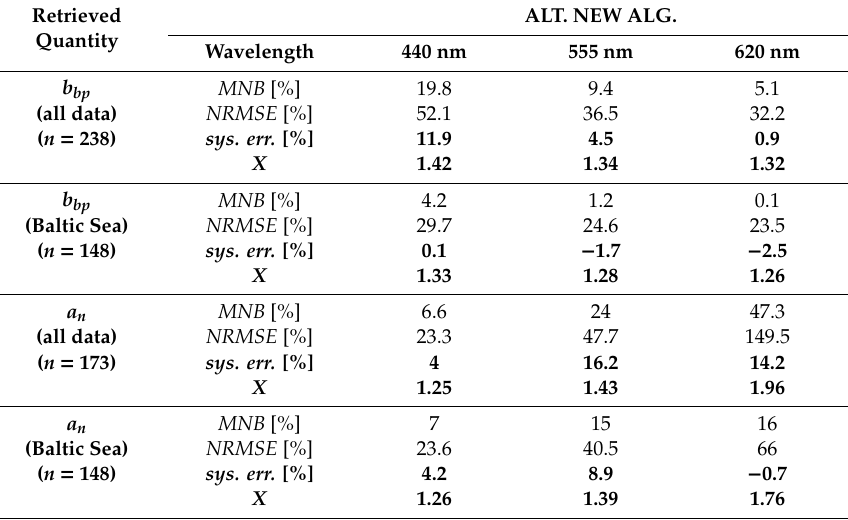
Table A2. Summary of estimation errors of coe ffi cients b bp and a n obtained when the alternative version of the new algorithm were applied to the entire dataset used in this work, as well as to the subsets representing the Baltic Sea data. The statistical parameters are the same as in Table